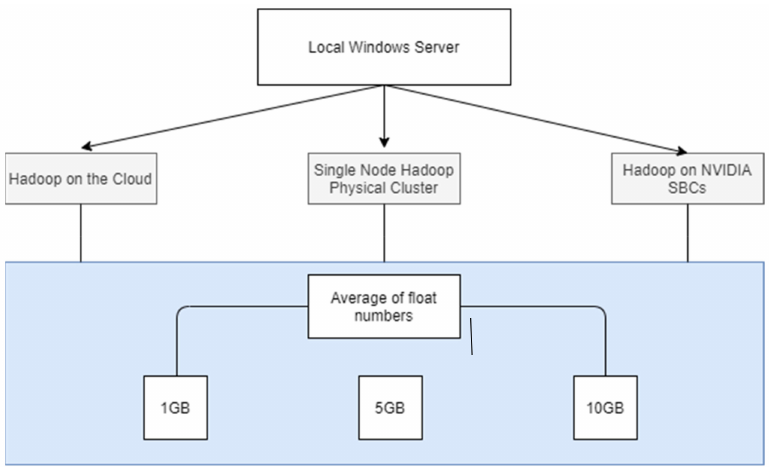
Figure 9. Experiment execution.